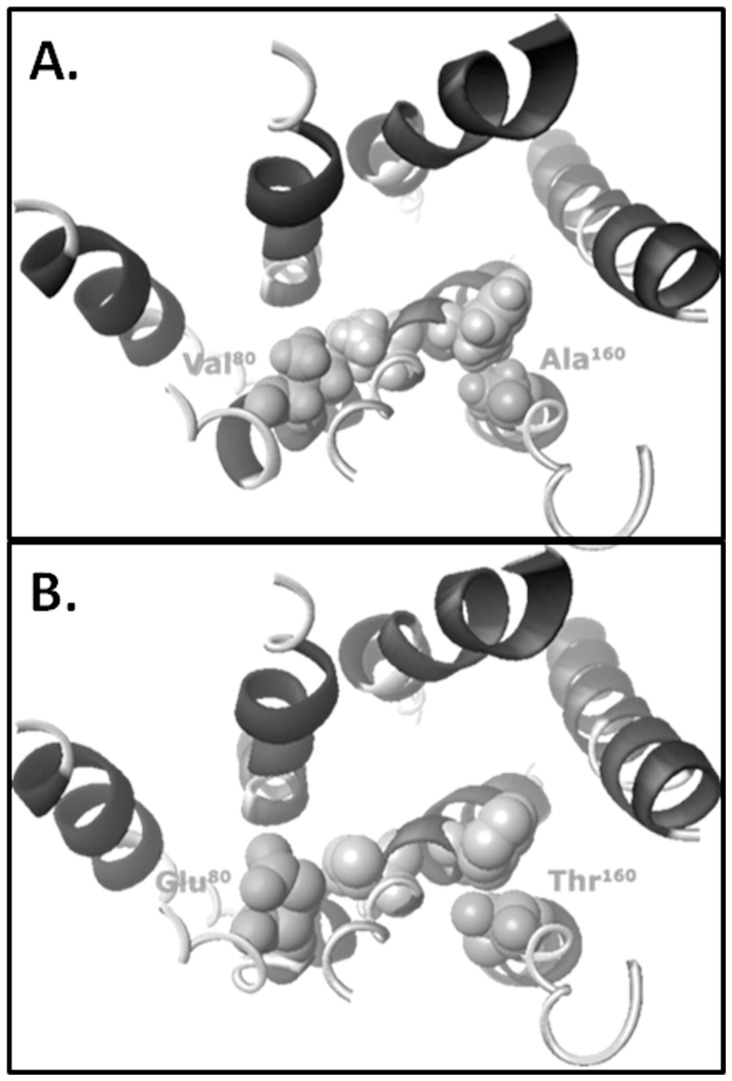
Binding Pocket Model of Disruption with Two hTP Variants.
A. A model of the wild-type binding pocket. The hTP receptor structure from the extracellular surface illustrates the putative binding pocket formed between the alpha helical bundles in the wild-type receptor. B. Binding pocket changes observed with the variants V80E, and A160T. Alteration of residue 80 to a glutamate shows an obstruction of the binding pocket by the protrusion of a charged side chain into the channel. Changing residue 160 to a threonine, on the other hand, results in a loss of interaction in the hydrophobic cluster.